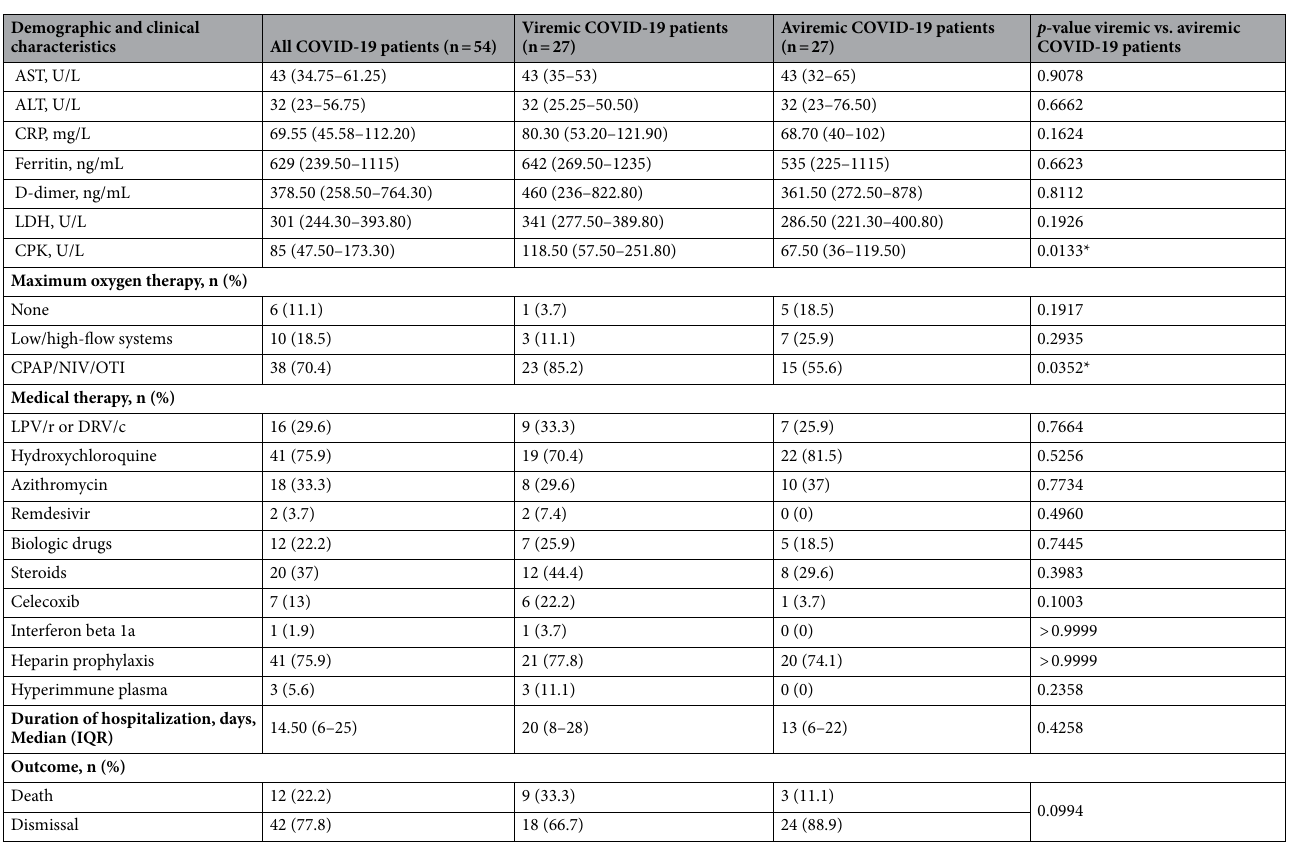
Table 1. Demographic and clinical characteristic of study subjects. COPD: chronic obstructive pulmonary disease; BMI: body mass index; P a O 2 arterial partial pressure of oxygen; F i O 2 fraction of inspired oxygen; AST: aspartate aminotransferase; ALT: alanine aminotransferase; CRP: C reactive protein; LDH: lactate dehydrogenase; CPK: creatine phosphokinase; CPAP: continuous positive airway pressure; NIV: noninvasive ventilation; OTI: orotracheal intubation; LPV/r: lopinavir/ritonavir; DRV/c: darunavir/cobicistat. Fisher exact test or Mann–Whitney U test; IQR: interquartile range. *Statistical significance at p